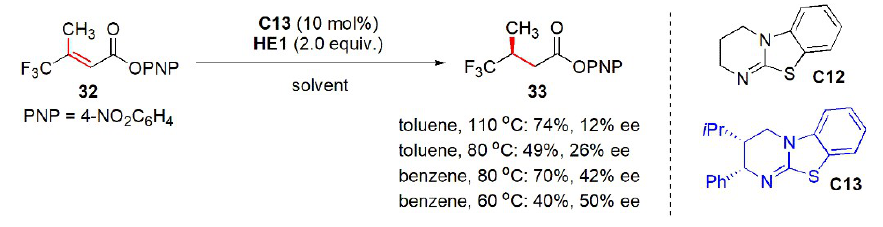
Figure 14. Isothiourea-catalyzed ETH of α,β-unsaturated esters [79].